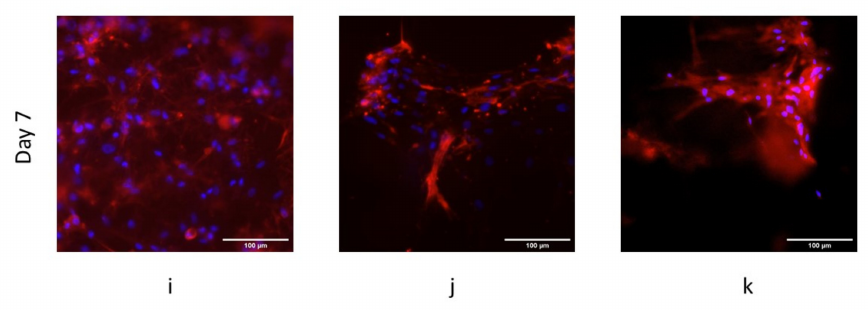
Figure 6. ( a , b ) Adhesion test to PLA with and without collagen coating. ( c – e ) Viability test at day 1 of cell culture. ( f – h ) Viability test at day 4 of cell culture. ( i – k ) Viability test at day 7 of cell culture.